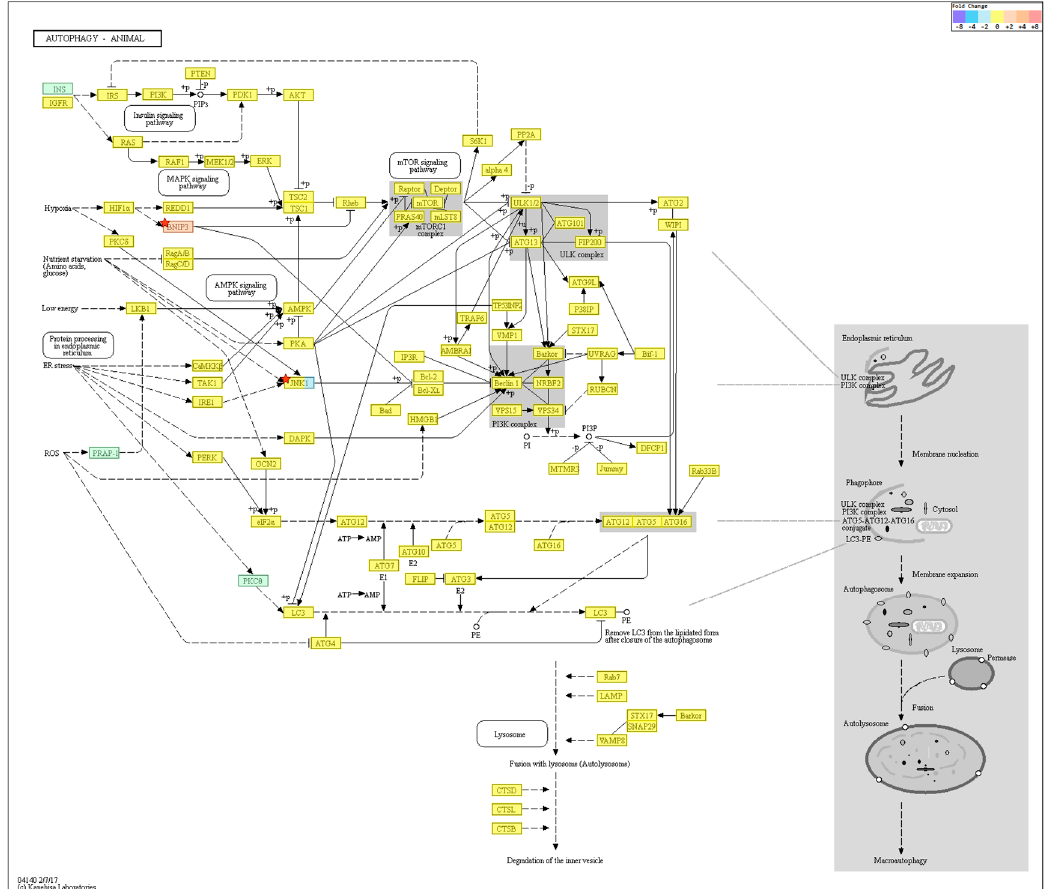
Figure 6. KEGG pathway analysis on autophagy. Among the genes, BNIP3 was upregulated and MAPK10 downregulated in the old cells but were not statistically significant. n = 4 in each group. Only those genes exhibiting log2 fold change (FC) > 2 and p < 0.05 were considered to be differentially expressed genes.